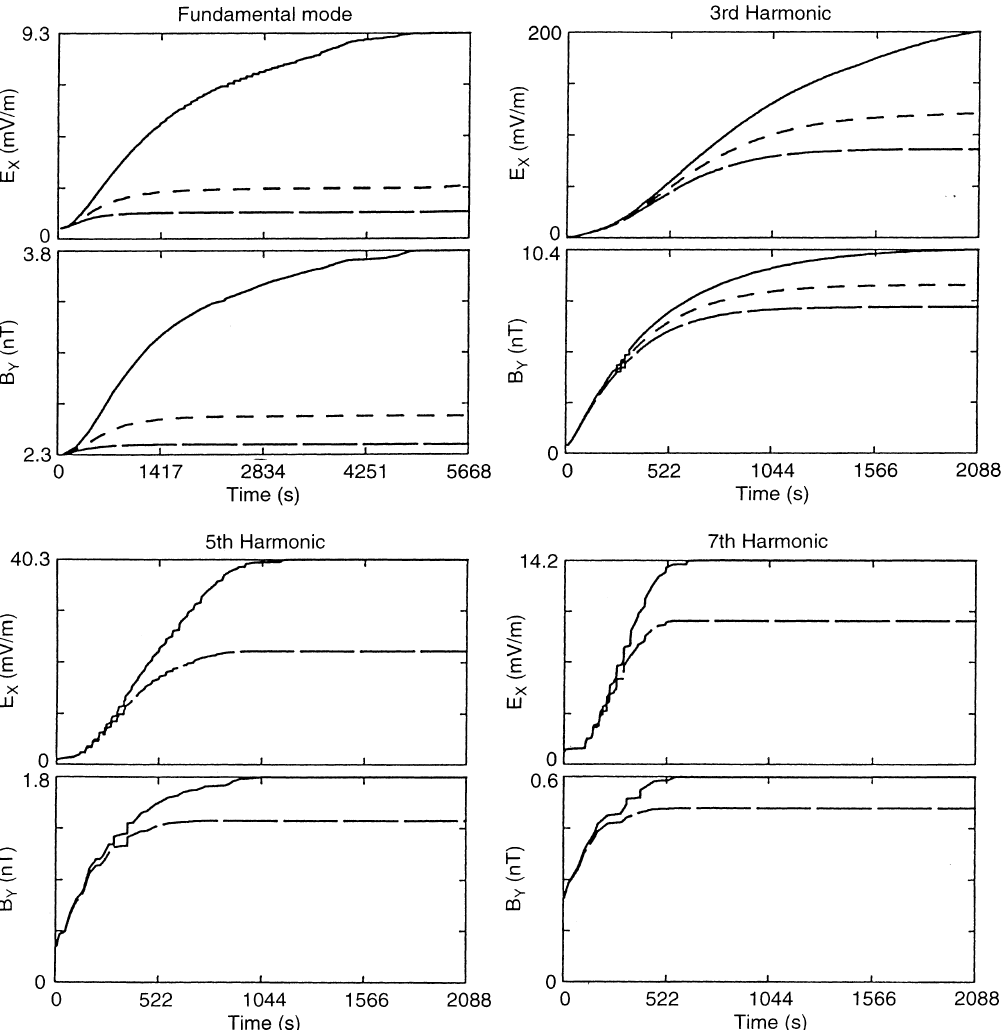
case (cid:82) P (cid:136) (cid:82) P (cid:136) 2 mho, and short-dashed curves in panels for the S N fundamental and third harmonic FLRs correspond to the asym- metrical case (cid:82) P (cid:136) 1 and (cid:82) P (cid:136) S N